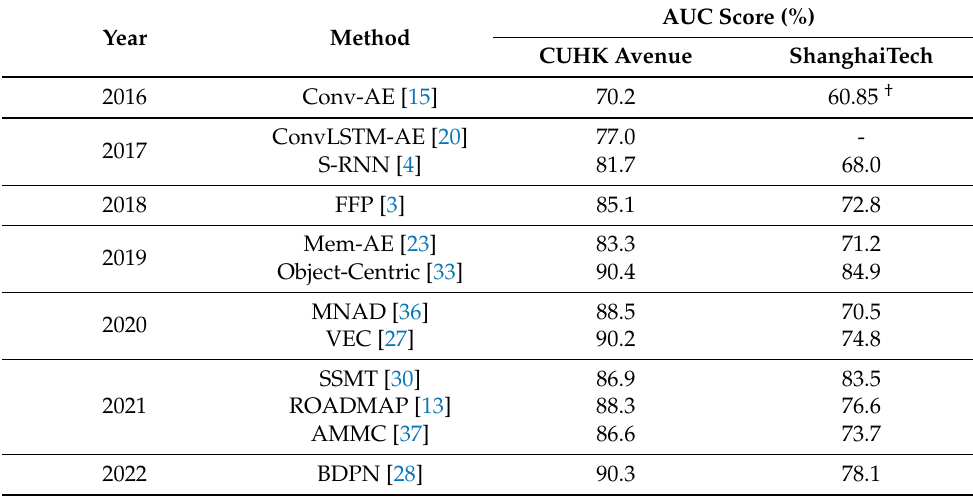
Table 1. Frame-level AUC scores of several semi-supervised methods, benchmarked on CUHK Avenue [11] and ShanghaiTech Campus [4] datasets. Results compiled by Feng et al. [39] Legend: † —Computed by Luo et al.